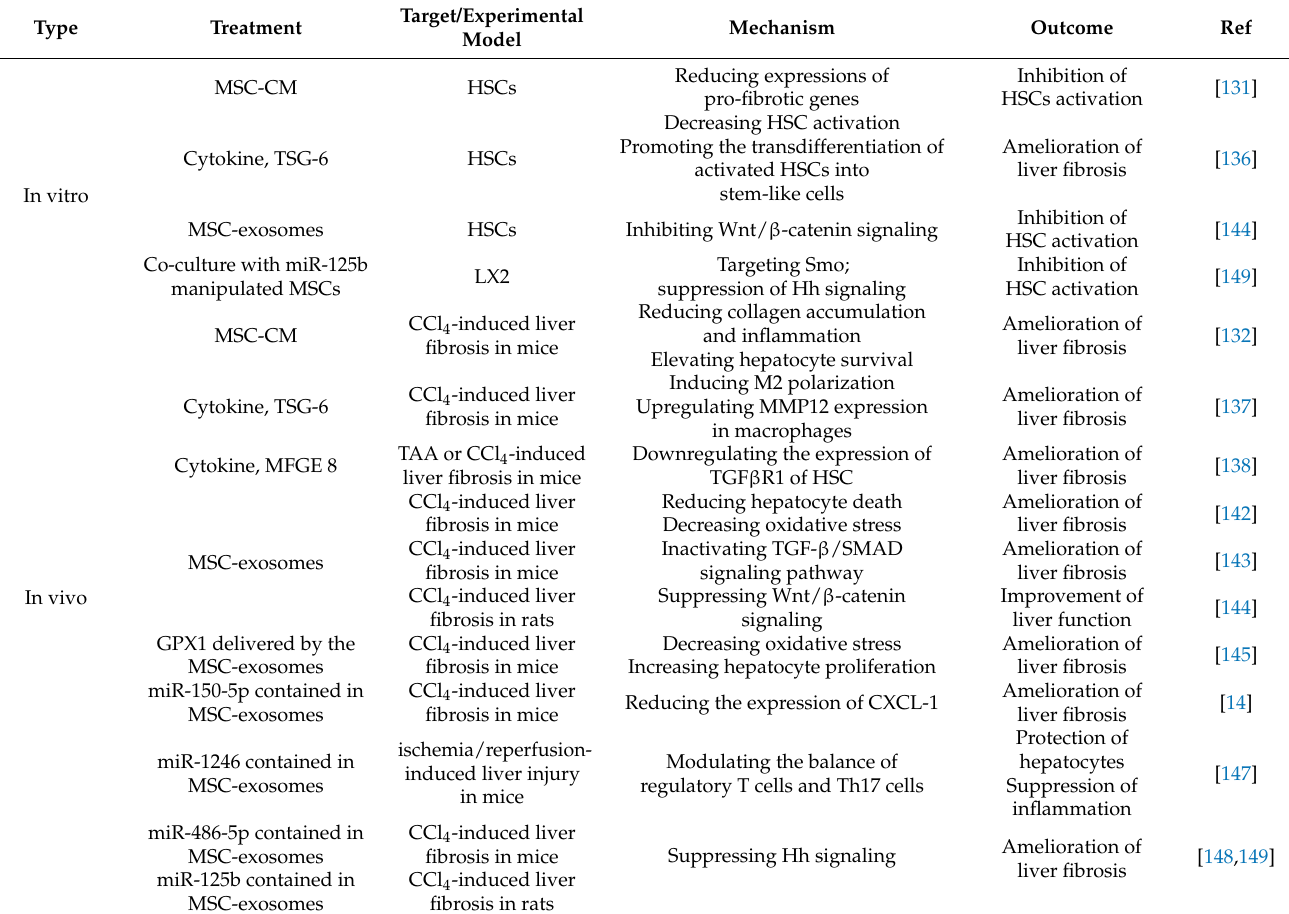
Table 3. Summary of MSC cell-free therapy for liver